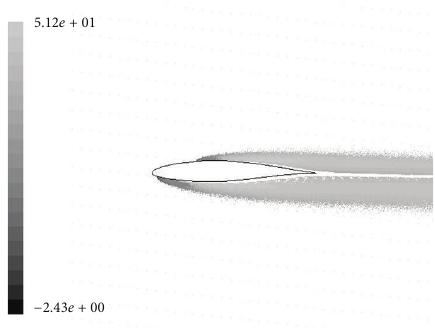
Figure 13: Raindrop traces at AOA = 0